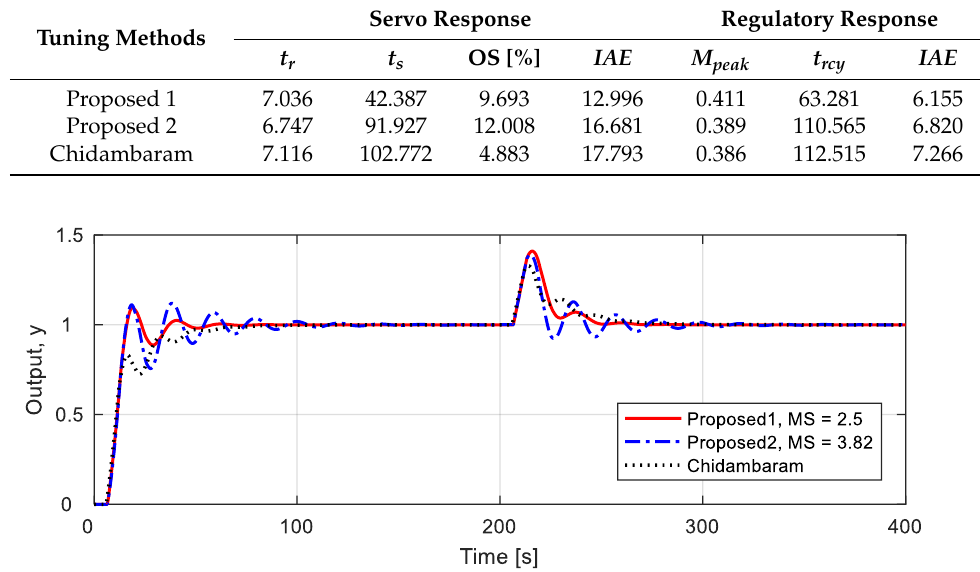
Figure 9. Unit step responses for 10% uncertainty process 𝑃 3 . Table 9. Performance comparisons for 10% uncertainty process 𝑃 3 .